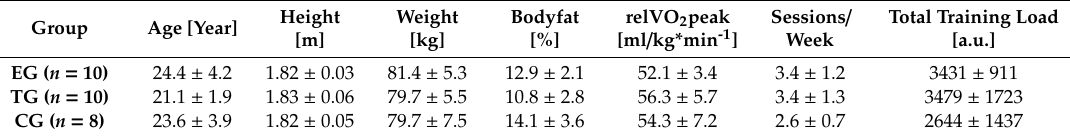
Table 1. Anthropometric data (mean ± SD) and Total Training Load (arbitrary units) during the 7-weeks intervention period calculated by Polar Team-2 Software according to training time spent in defined heart rates